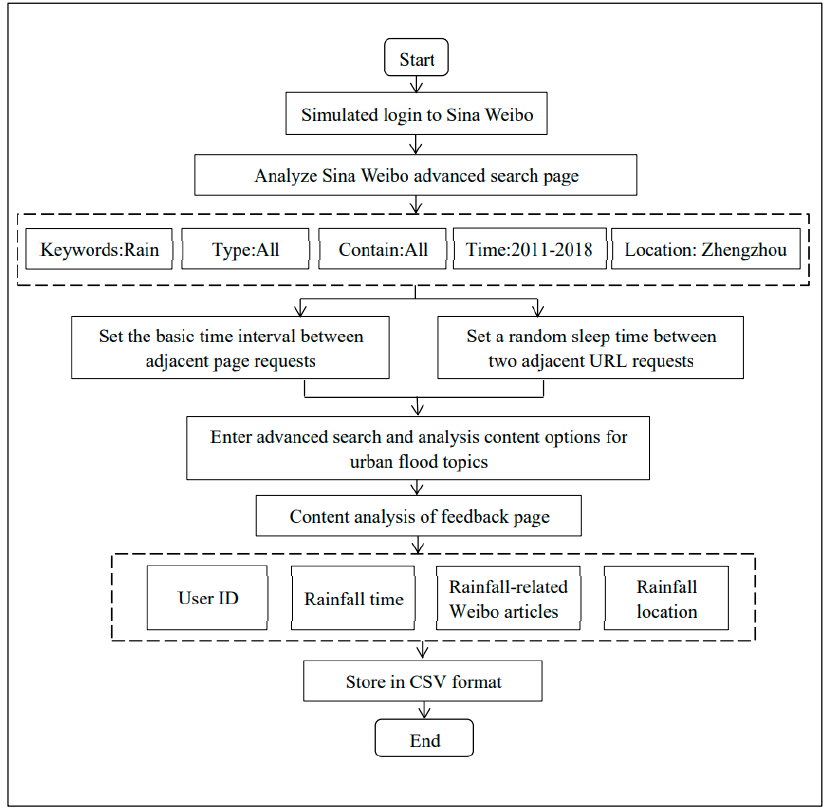
Figure 4. Flow chart of the Sina Weibo rainfall data crawler.